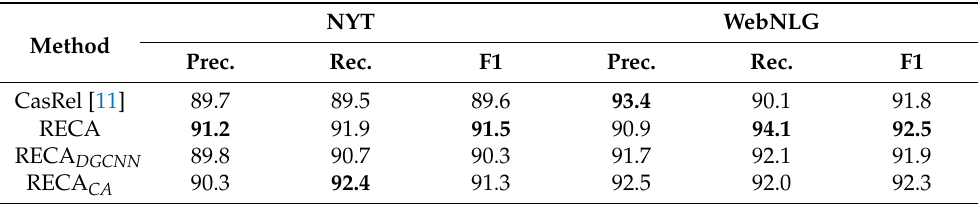
Table 3. Results for ablations experiments with the NYT and WebNLG datasets. The best scores are in bold font.